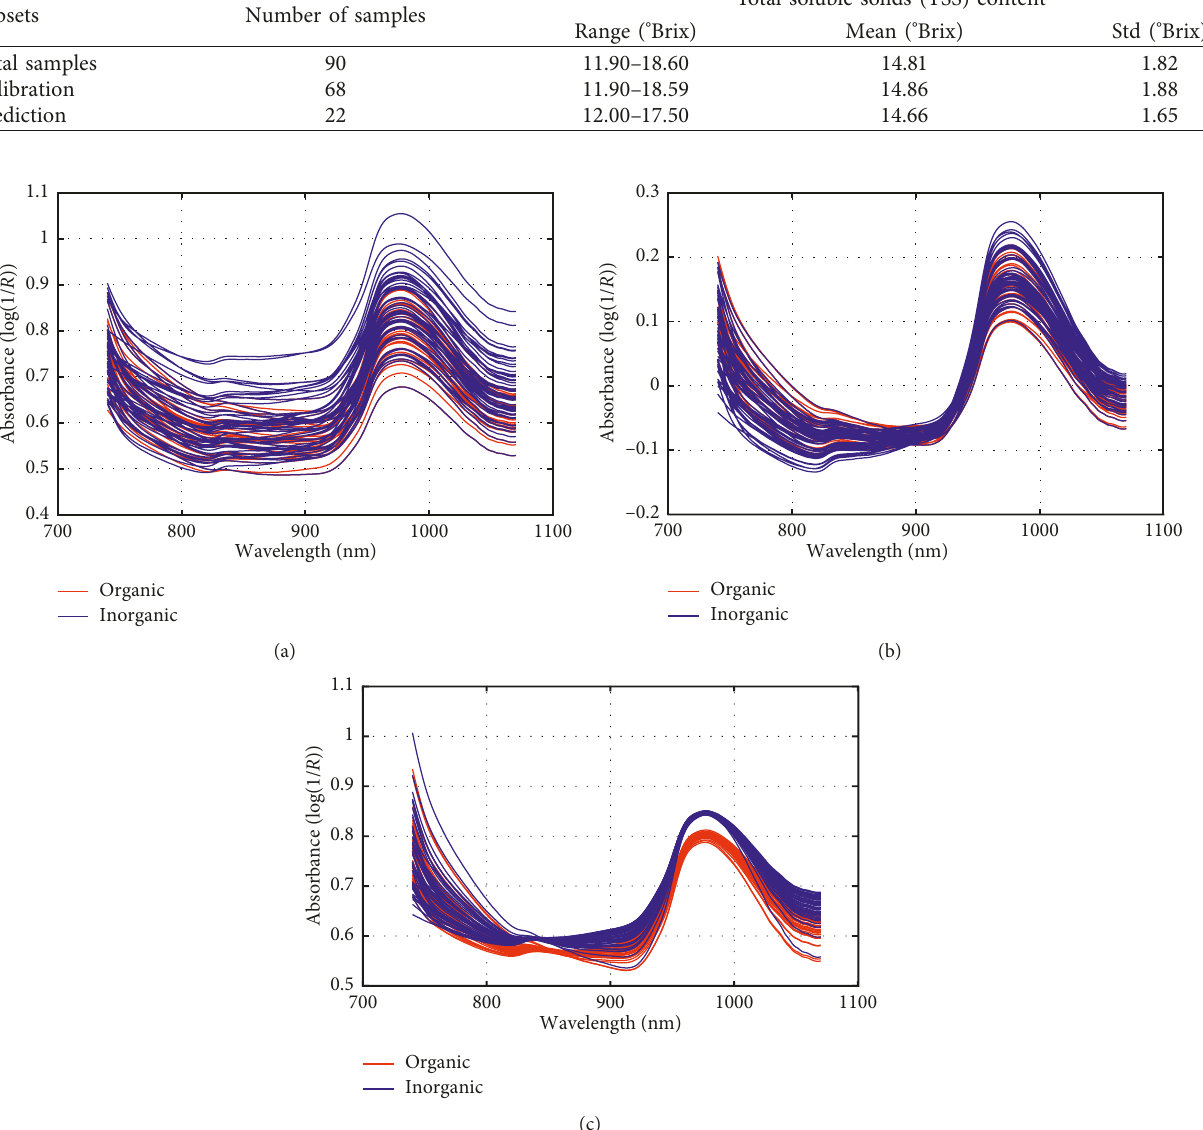
Figure 2: NIR spectra of pineapple fruits. (a) Raw, (b) pretreatment with MC, and (c) pretreatment with